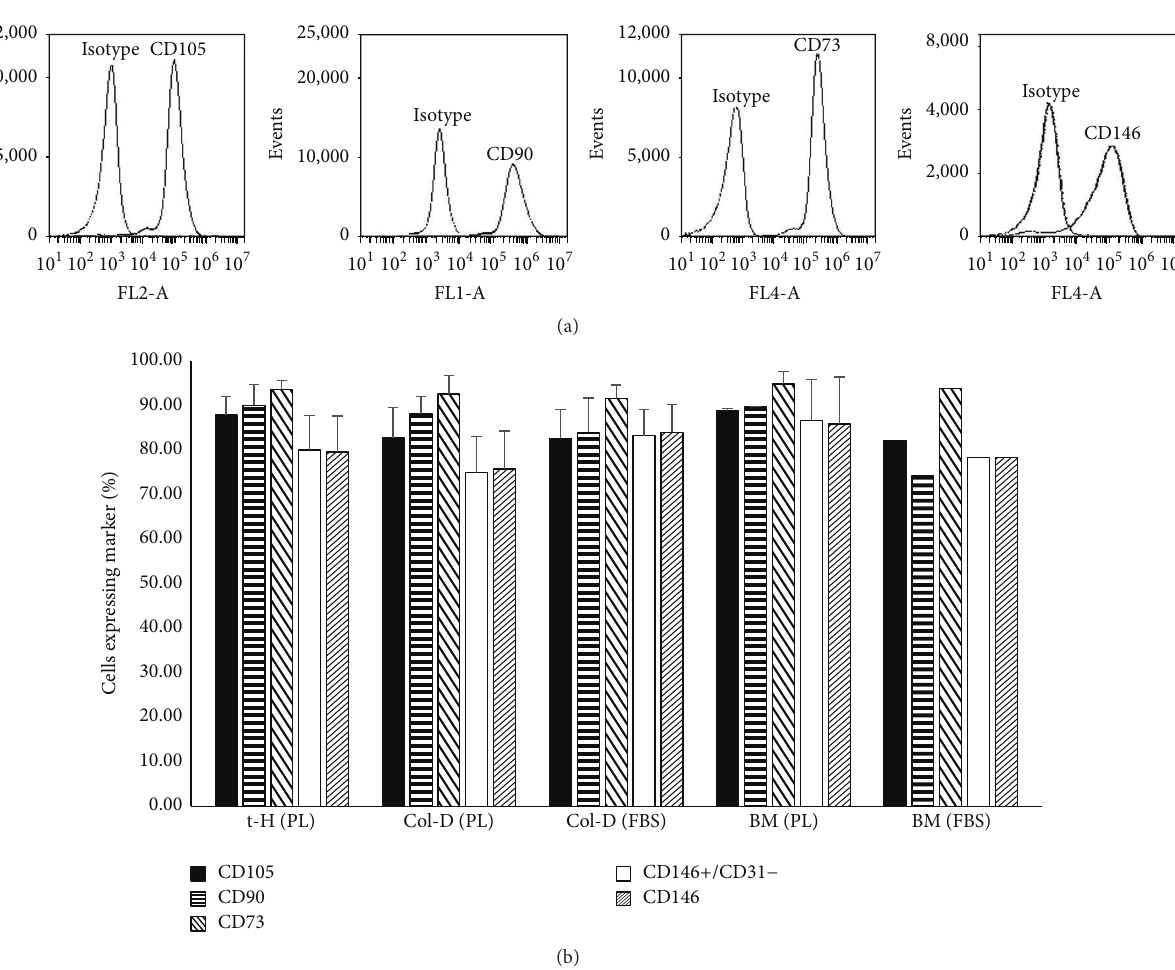
Figure 5: Umbilical cord MSCs express characteristic mesenchymal cell surface markers by flow cytometry. (a) Representative histograms from passage 3 demonstrate expression of mesenchymal markers (CD90, CD105, CD73, and CD146) in cultured UC-MSCs. Histograms show antibodies with their respective isotype controls. (b) Bar graph demonstrates the mean expression of different mesenchymal markers by cultured MSCs derived from umbilical cord ( 𝑛 = 8 ). CD45, CD34, CD14, CD20, and CD31 are not shown since expression levels were less than 2%. Bone marrow MSCs were used as controls for cell marker expression. Each bar represents mean ±